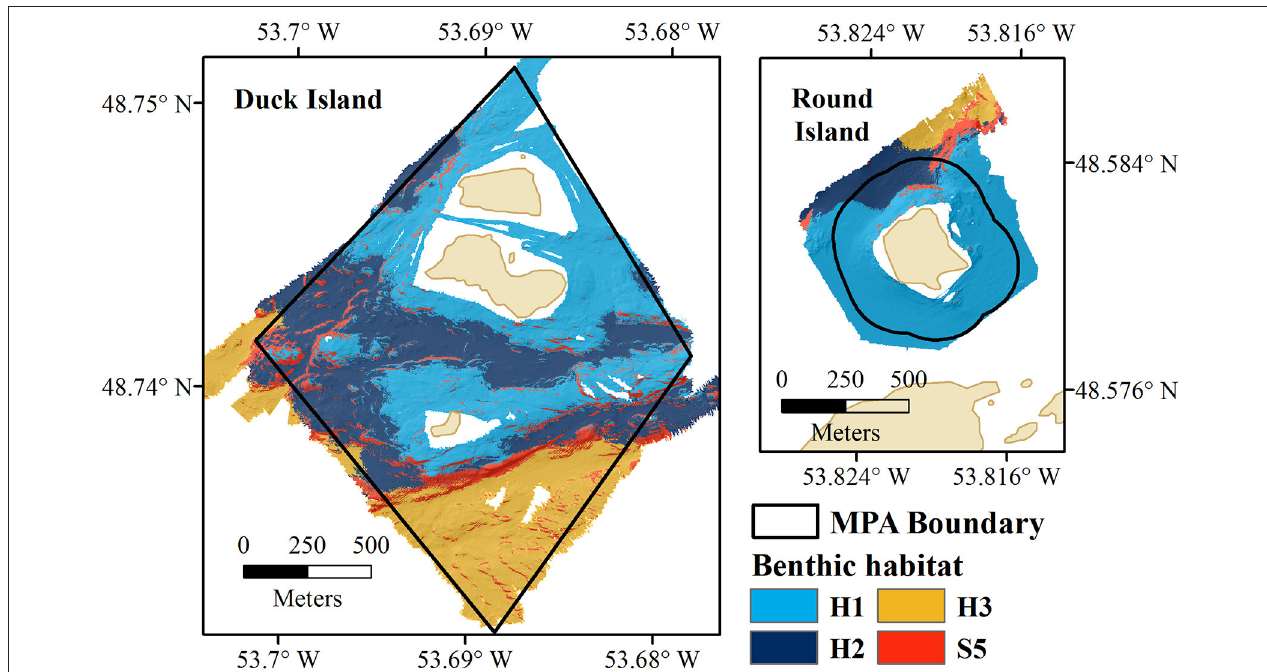
FIGURE 7 | Benthic habitats of the Eastport MPA (Duck Island and Round Island); H1, shallow, rocky habitat; H2, sand and cobble; H3, sand; and S5, high profile bedrock features.